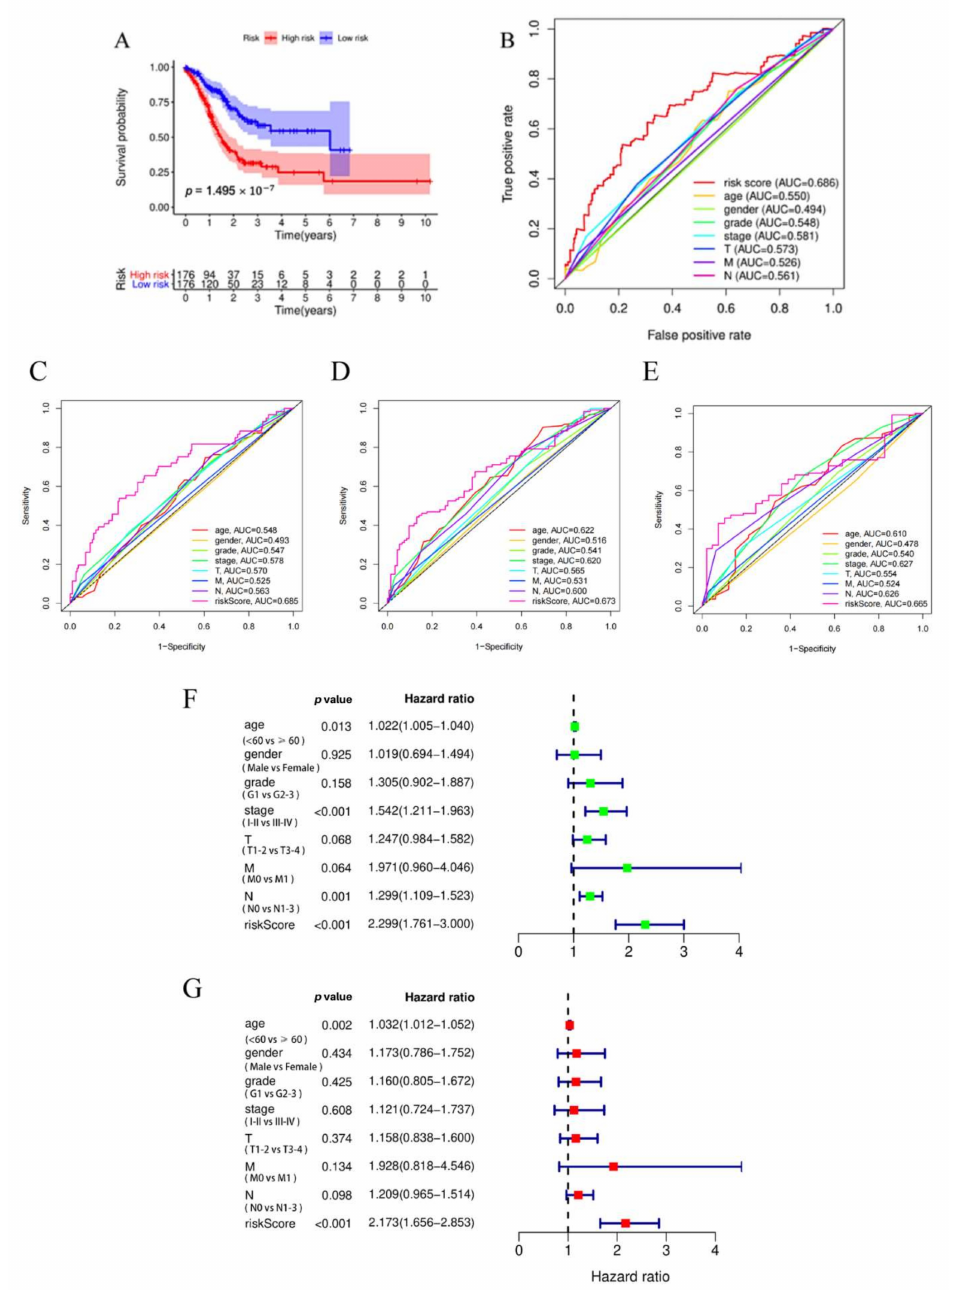
Figure 3. The protein risk prognostic model had good prognostic predictive value and was an independent prognostic factor for STAD patients. ( A ) The survival analysis for STAD patients between high-risk and low-risk groups. ( B ) Time-dependent ROC of the risk model; the AUC was assessed at 1, 2, and 3 years (AUC = 0.685, 0.673, and 0.665). ( C – E ) Time-dependent ROC curve analysis revealed that the predictive model has higher accuracy and sensitivity compared to the clinical features. ( F , G ) The univariate and multivariate Cox analysis revealed that this risk model was an independent prognostic factor for STAD